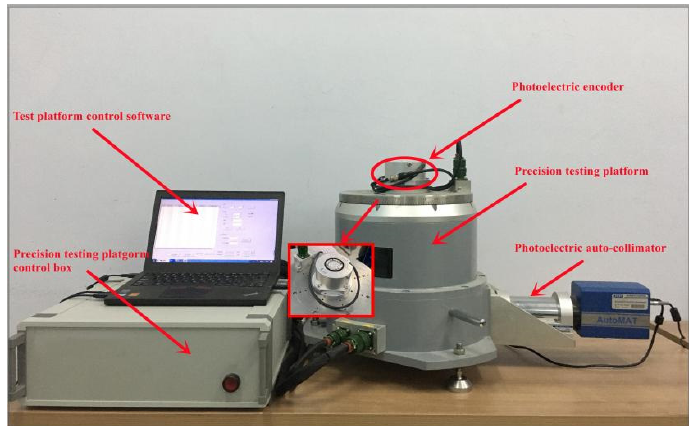
Figure 16. Moiré grating interpolation error precision detection platform.